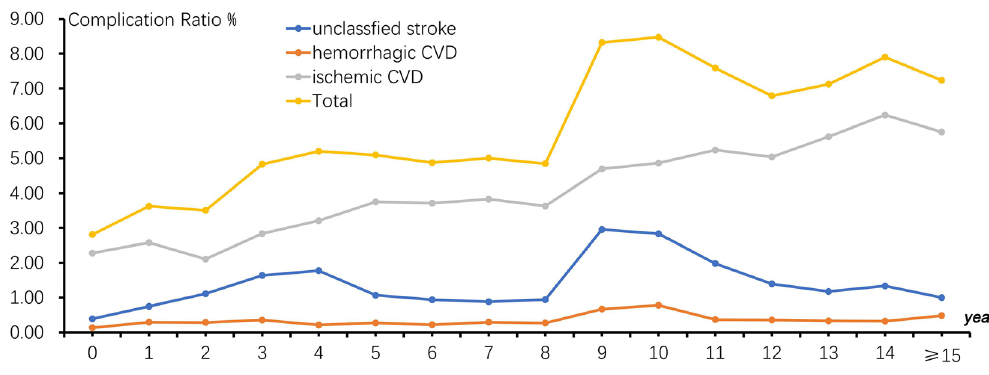
Figure 4. The complication ratio of CVD and the duration of HP